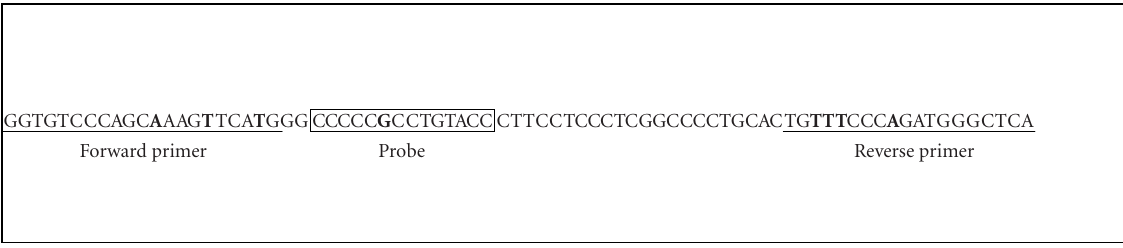
Figure 1. Probe and primer design. The forward and reverse primers, as well as the probe, were drawn using the Primer Express software. The target sequence is located in intron 6. The forward primer has a temperature of 58 ◦ C for a length of 19 bases including 4 discriminating ones (in bold) for the CYP2D6 gene related to the CYP2D7/8 sequences; the reverse primer has a temperature of 58 ◦ C for a length of 21 bases, including 3 nucleotides specific to the CYP2D6 gene (in bold). The MGB probe corresponds to the sequence framed on the diagram with one discriminating nucleotide (in bold). The G base (in bold) is another discriminating nucleotide present in the